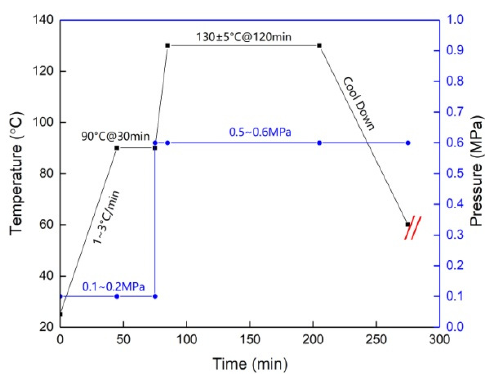
Figure 5. Autoclave and compression molding parameters for resin epoxy CF or RF laminates.